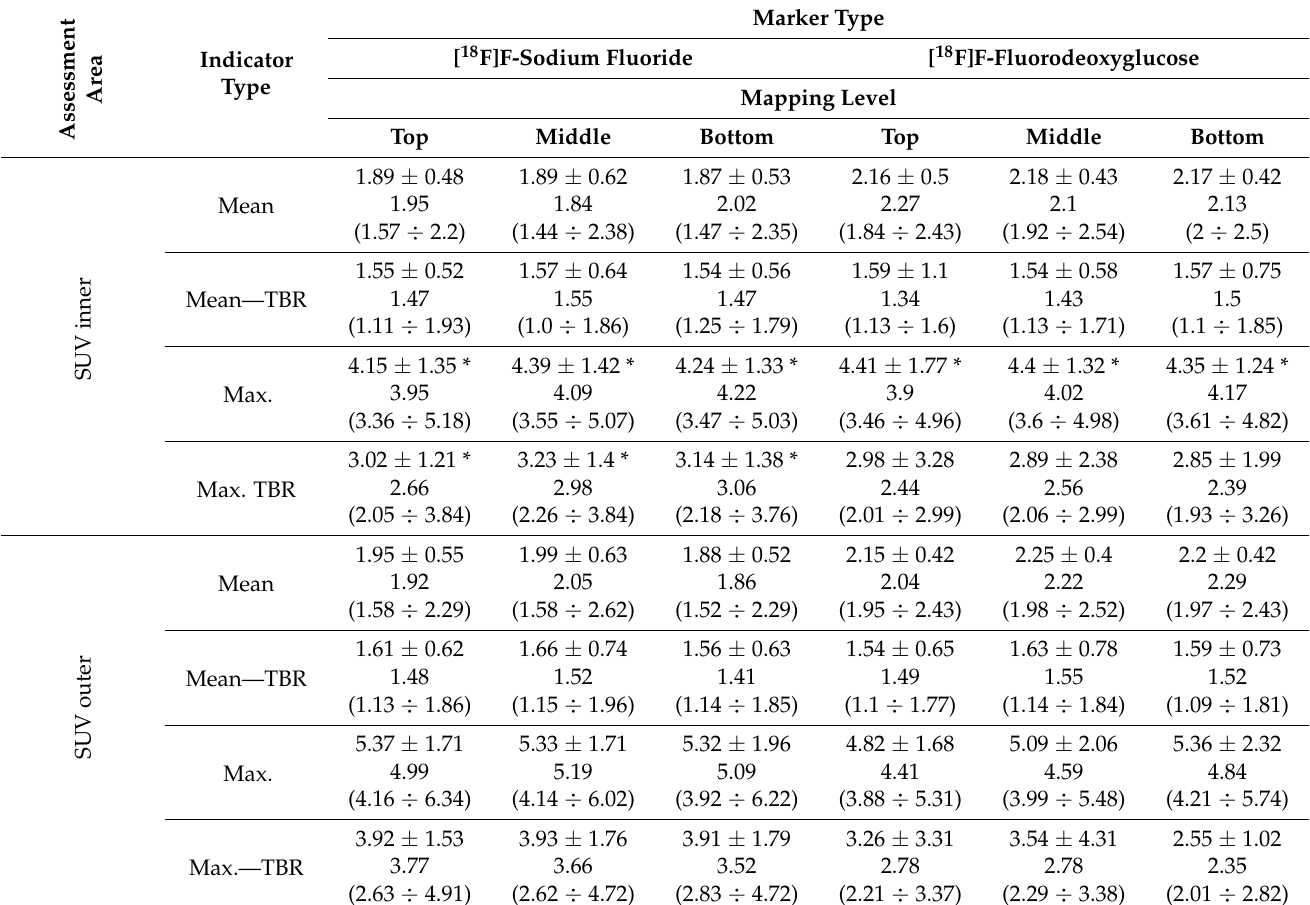
Table 3. Positron emission tomography-computed